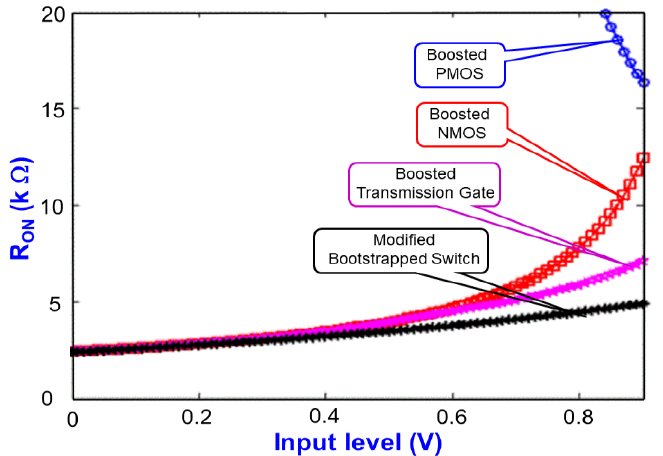
Figure 5. Simulated on-resistance with respect to the input levels of various switches.